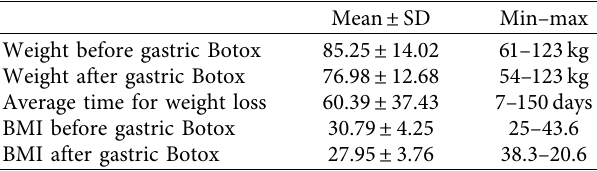
Table 2: Average weight and BMI loss.